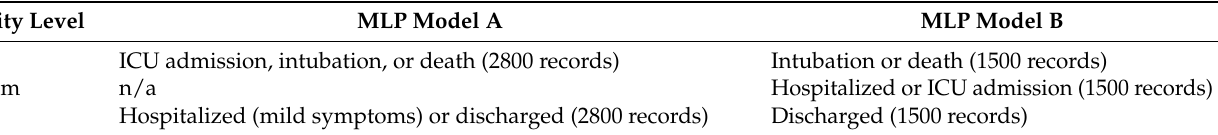
Figure 1. MLP machine learning models for predicting patients’ level of disease severity and dete- rioration. Table 3. Severity levels predicted by the model.